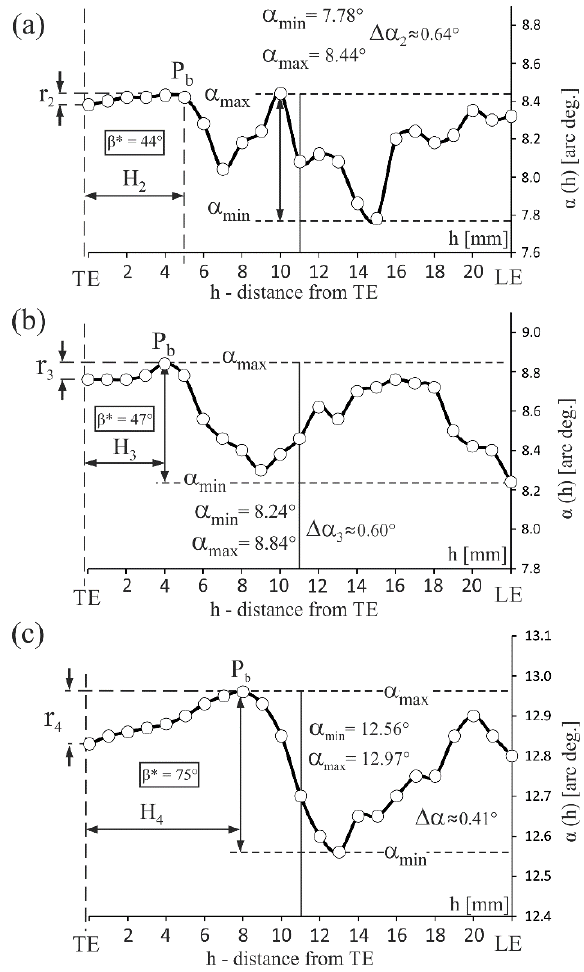
Figure 3. Examples of the α angle distribution along the camber line of the S u surface for blades obtained at the withdrawal rate of ( a ) 2 mm/min.; ( b ) 3 mm/min. and ( c ) 4 mm/min.